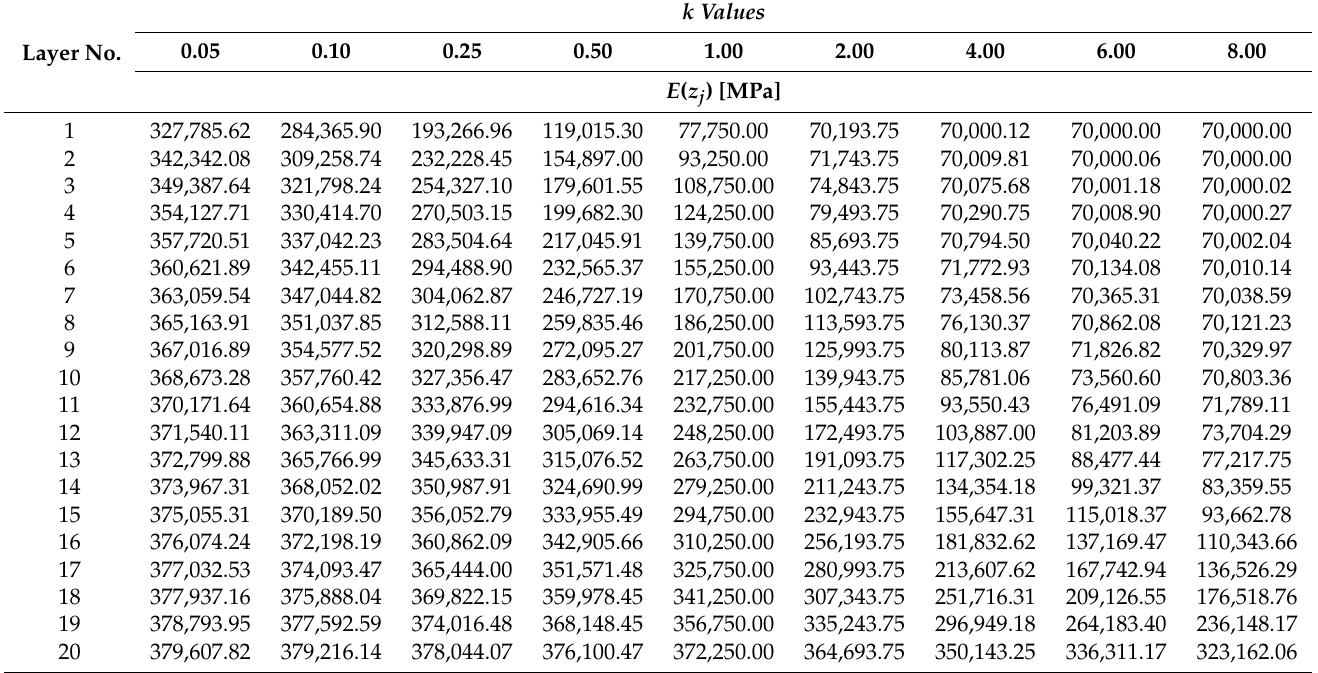
Table 3. The values of Young’s modulus E ( z j ) for different k values for 20 layers.